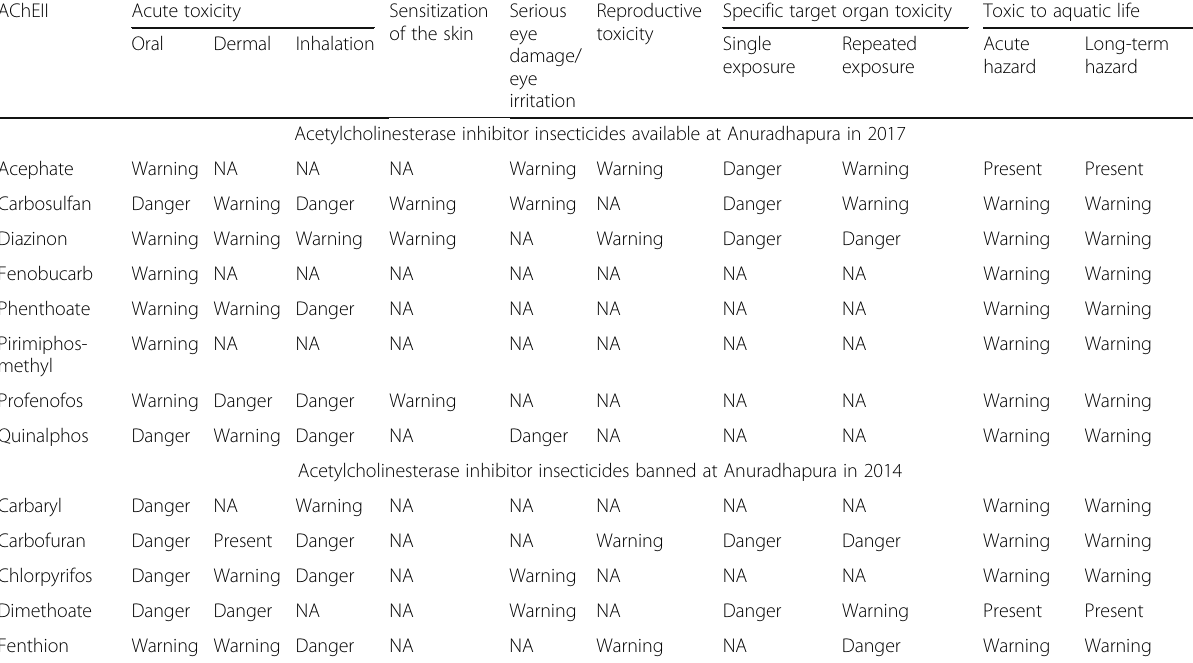
Table 1 Toxicity profile of available and banned acetylcholinesterase inhibitor insecticides, AChEII study, Anuradhapura, 2017